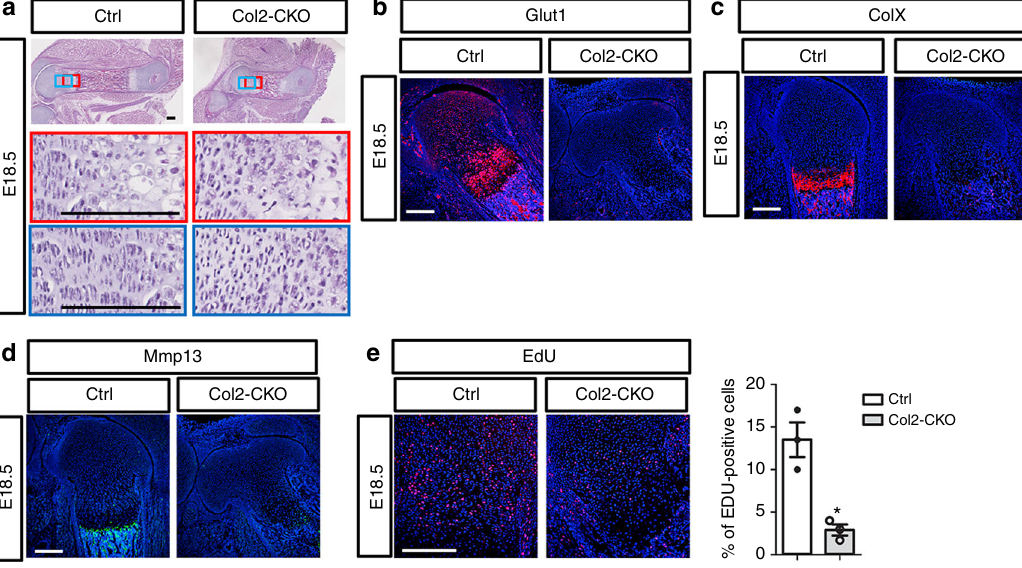
Fig. 6 Deletion of Glut1 with Col2-Cre impairs chondrocyte proliferation and maturation. a H&E staining of longitudinal femoral sections from normal (Ctrl) versus Col2-Cre; Glut1 f/f (Col2-CKO) littermate embryos at E18.5. b – d Immuno fl uorescence staining of Glut1 ( b ), ColX ( c ) or Mmp13 ( d ) on E18.5 femoral sections. e EdU labeling of chondrocytes in the femur at E18.5. Signal is in red. * p < 0.05, n = 3 mice, error bar indicates SD, two-tailed Student ’ s t -test. Scale bar: 200 µ